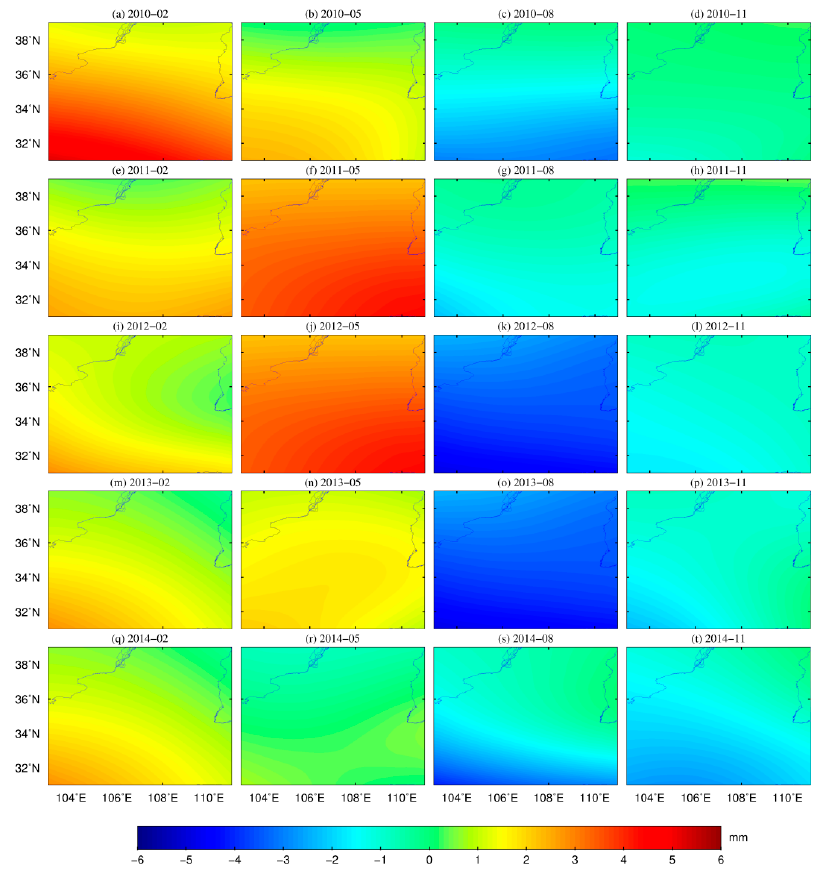
Figure 5. The monthly and seasonal vertical deformation maps driven by changes in terrestrial wa- ter